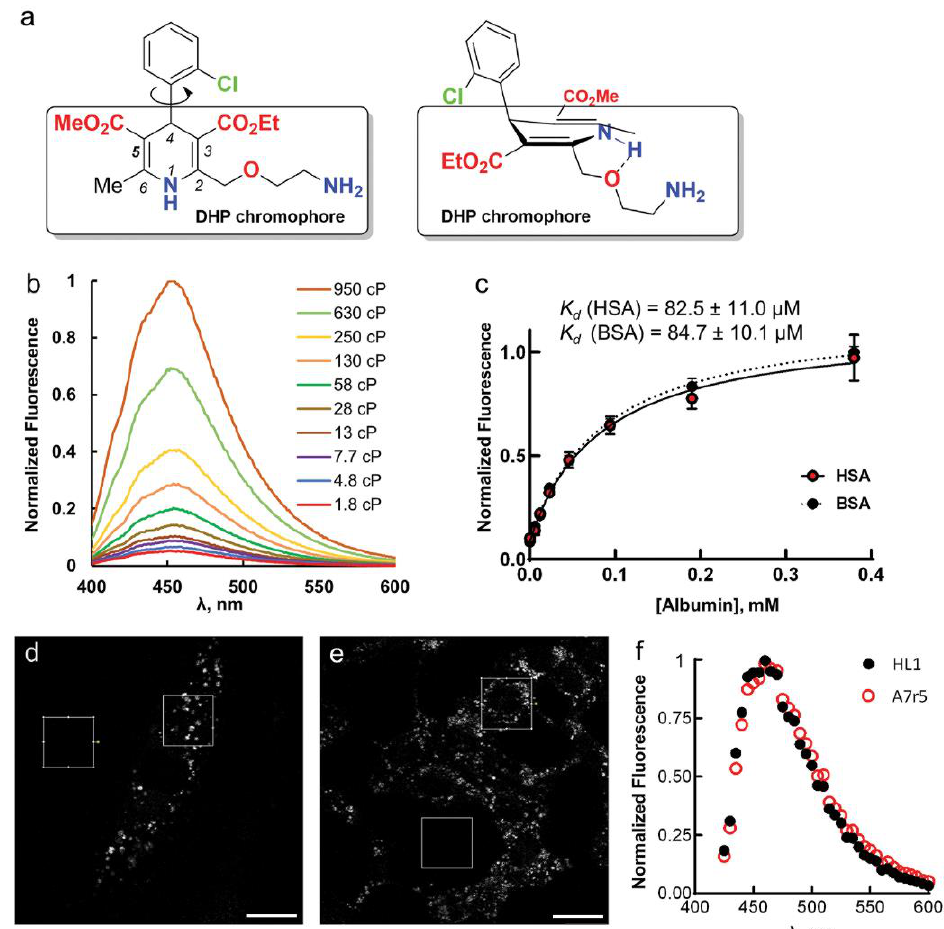
Figure 1. ( a ) 2-((2-Aminoethoxy)methyl)-4-(2-chlorophenyl)-3-ethoxycarbonyl-5-methoxycarbonyl-6-methyl-1,4-dihydropyridine, amlodipine. Planar structure and molecular geometry according to the crystallographic data are shown [12]. DHP chromophore is framed. The dashed line shows a hydrogen bond. ( b ) Fluorescence spectra of 5 µM AML in MeOH/glycerol mixtures of different viscosity. ( c ) Equilibrium binding of ( S )-AML to BSA and HSA measured by titrating 5 μM ( S )-AML with 6 µM to 0.38 mM BSA/HSA. Values are mean ± S.D., n = 3 independent measurements. ( d , e ) Confocal images of living A7r5 ( d ) and HL-1 ( e ) cells stained with 5 µM AML obtained with 405 nm excitation laser. Scale bars—15 µm. To obtain the emission spectrum, the mean signal was measured in a selected region of interest (15 × 15 µm 2 ) and in an equivalent region without the cells. The spectra from three regions of interest (ROIs) were averaged and the background was subtracted to yield spectra shown in ( f ).